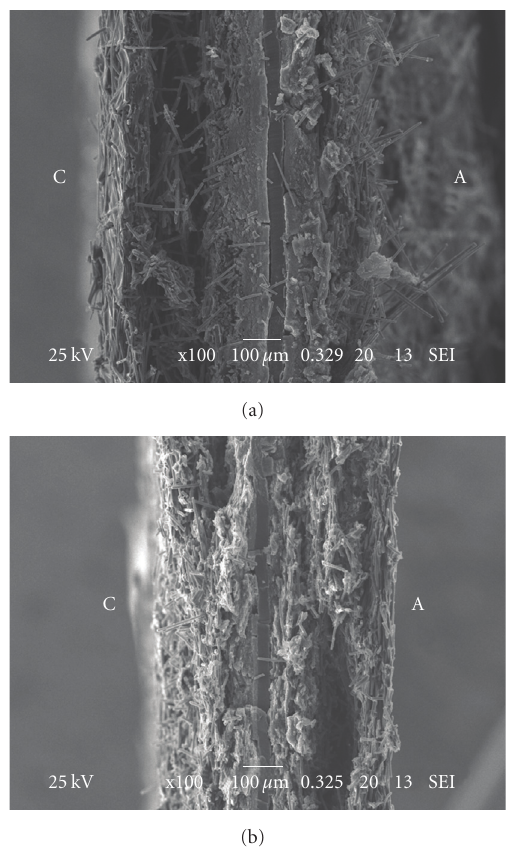
Figure 3: SEM images of MEA with Nafion 112 (a) and Nafion/MMT (b) after long-term